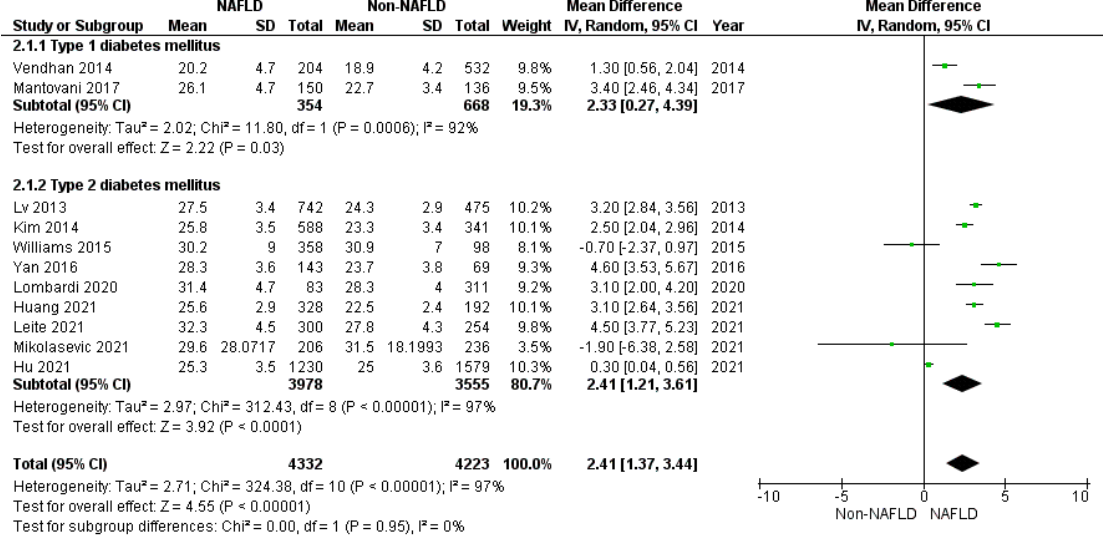
Figure 3. Forrest plot demonstrating the body mass index (BMI) comparing diabetic patients with and without NAFLD. Data are expressed as the mean difference and evaluated by applying the random effect model.